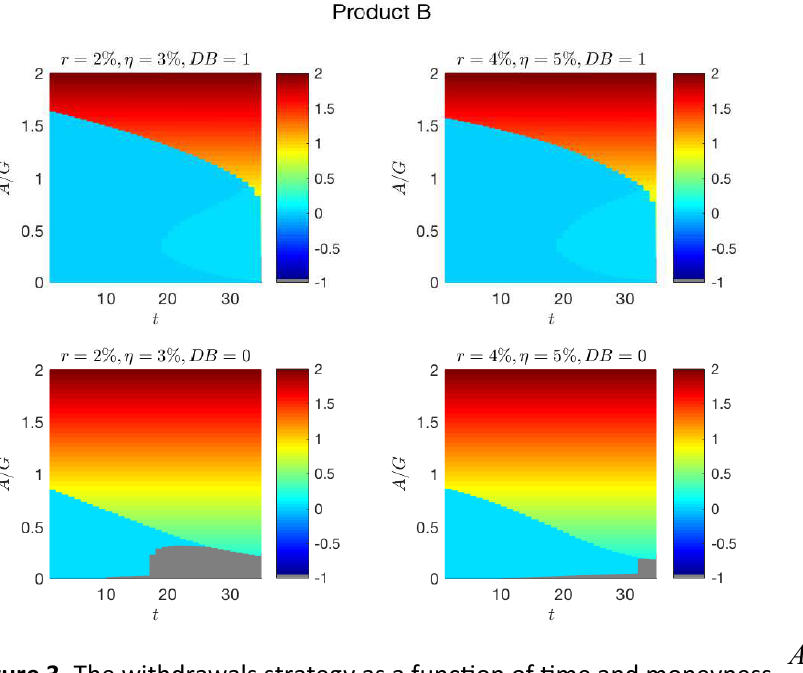
Figure 3. The withdrawals strategy as a function of time and moneyness